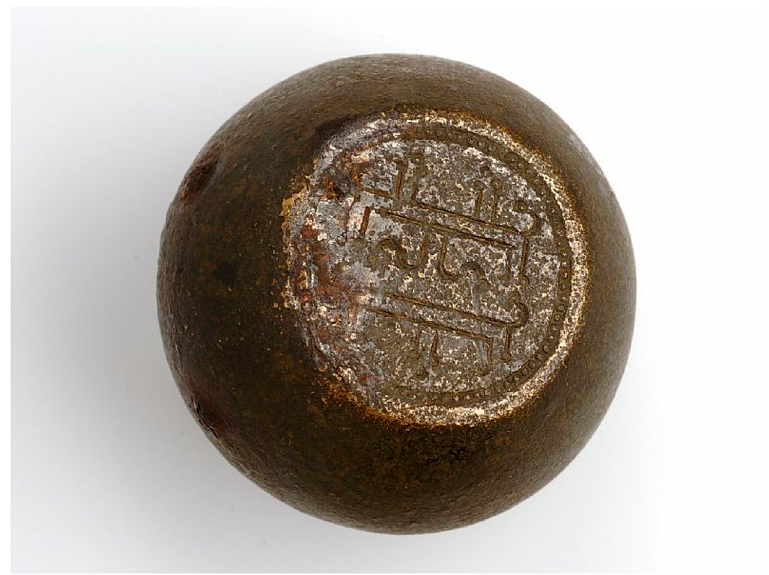
Figure 5. Iron weight with bronze casing and Arabic-like inscription ©Christer Åhlin, Swedish History Museum (CC BY 2.5 SE license).